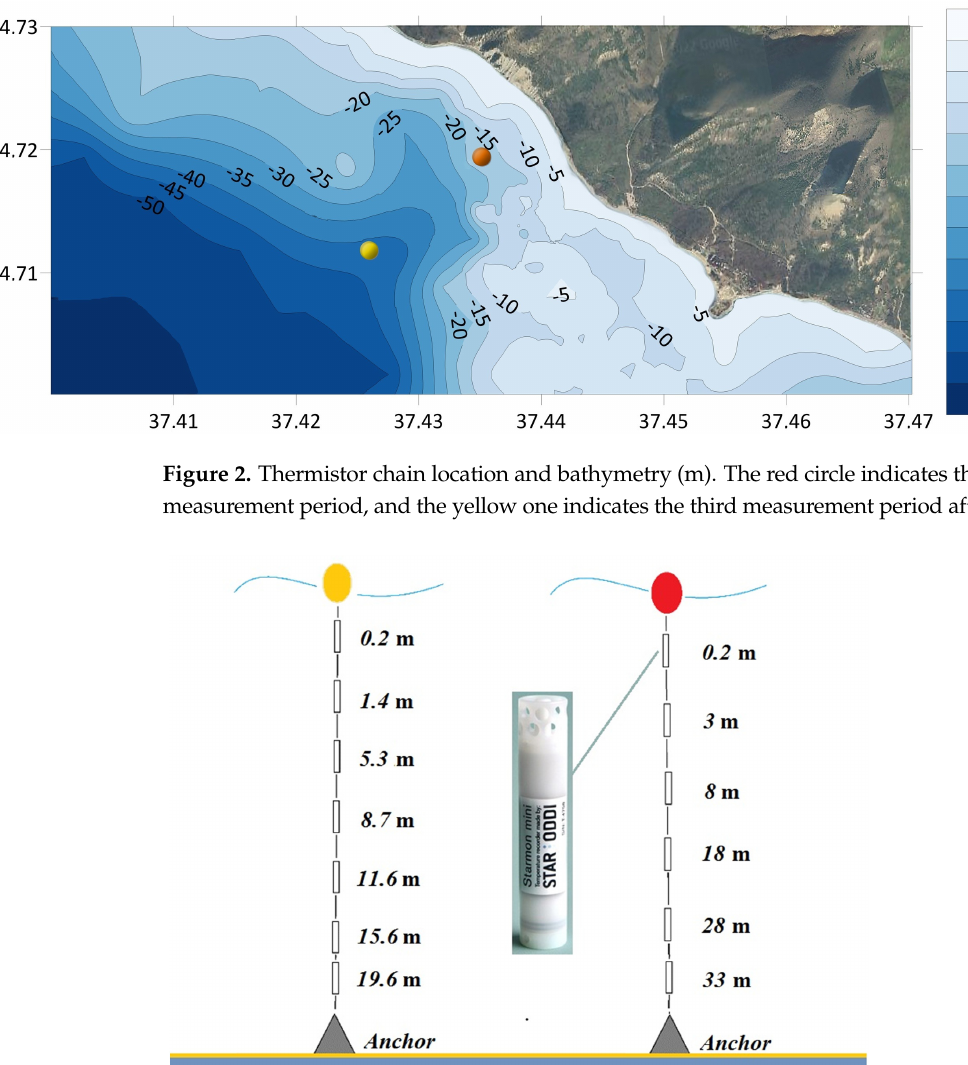
Figure 3. Thermistor chain station. Yellow buoy indicates second measurement period, and red buoy indicates third measurement period. indicates third measurement